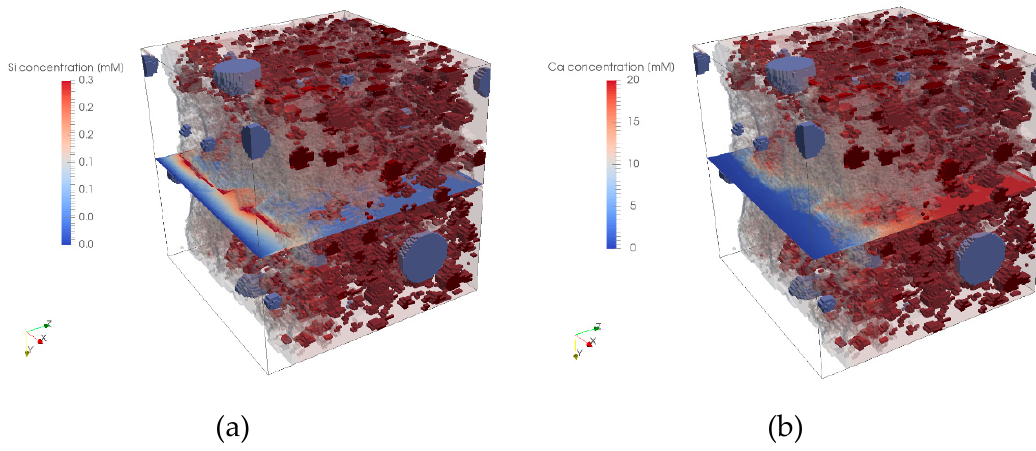
Figure 8. Dissolved Si concentration (cross-section) at the degradation front ( a ) and dissolved Ca concentration cross-section ( b ).